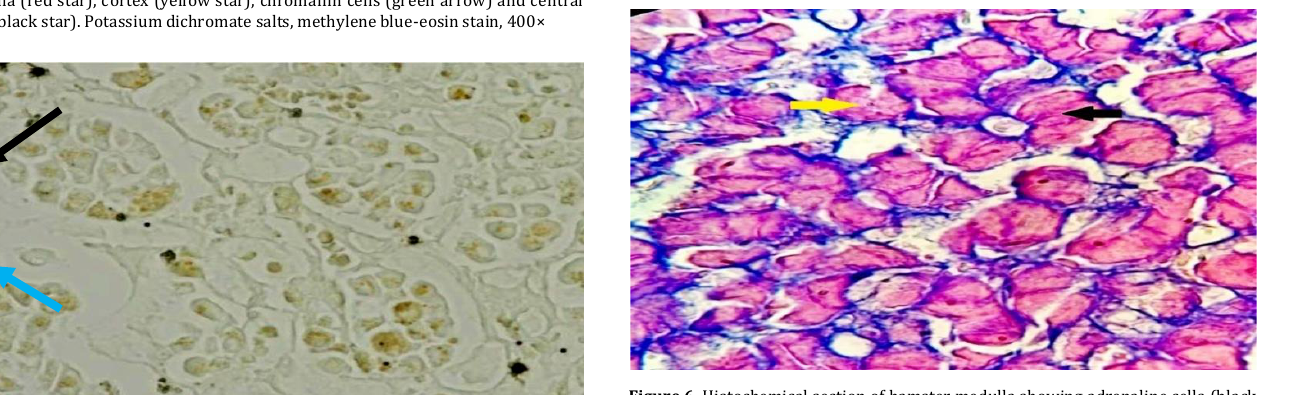
Figure 6. Histochemical section of hamster medulla showing adrenaline cells (black arrow) and noradrenaline cells (yellow arrow). Methylene blue-eosin stain,1000